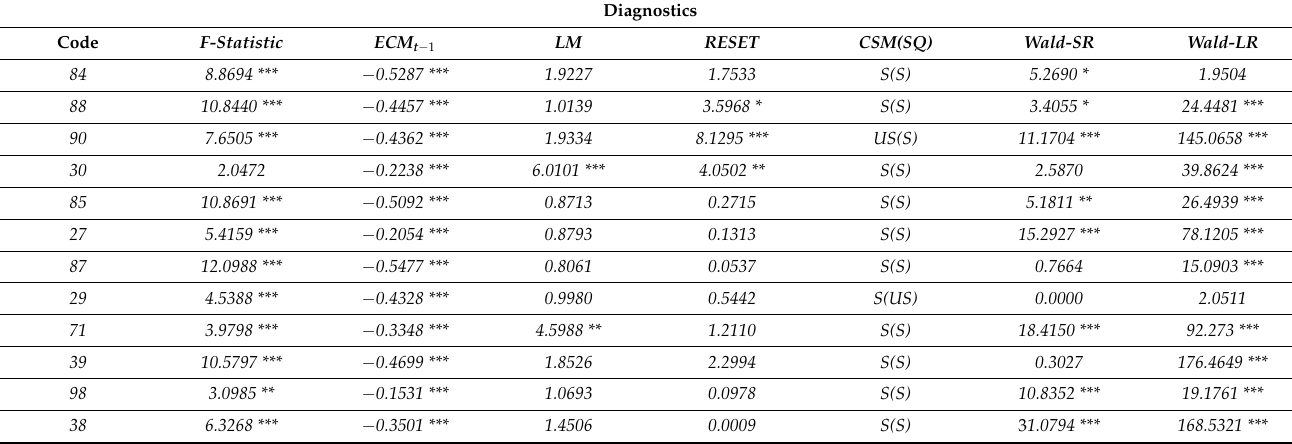
Table 9. Diagnostics in the nonlinear ARDL export demand model